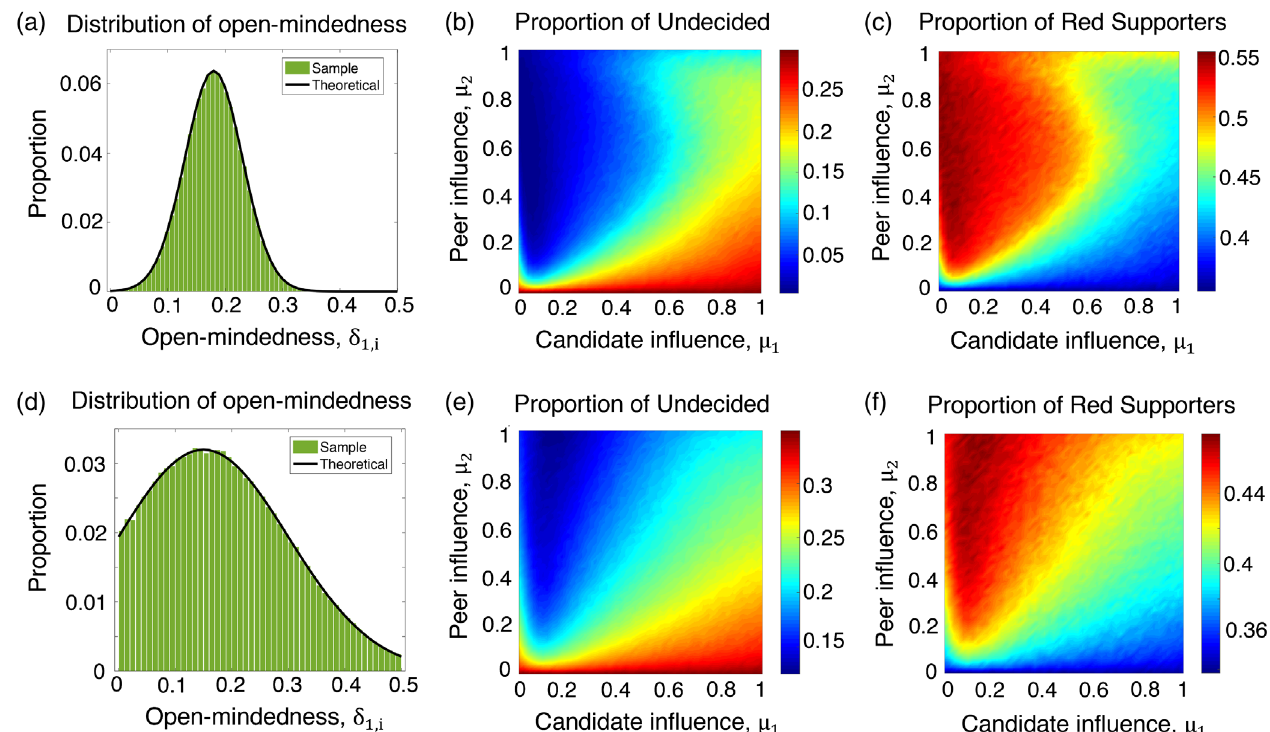
FIG. 10. Effect of candidate influence and peer influence on polarization under heterogenous population open-mindedness. We run simulations with mild heterogeneity in open-mindedness (a) – (c) and strong heterogeneity in open-mindedness (d) – (f). Higher levels of heterogeneity change the relationship between candidate influence, peer influence, and polarization. In higher heterogeneity and high- peer-influence conditions, candidate influence has less of a dampening effect on polarization. Furthermore, higher levels of heterogeneity generally lead to less polarization across all combinations of influence parameters. Simulation results are averaged over 30 independent runs. Parameters: All simulations begin from an ER graph with N ¼ 10 4 , h k i ¼ 6 , Ω T ¼ 0 . 5 , θ 1 ¼ 0 . 2 , and θ 2 ¼ 0 . 7